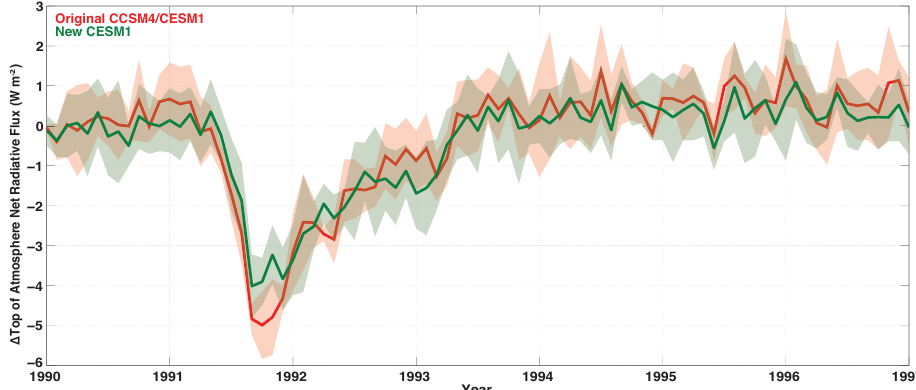
Figure 4. Global, monthly, ensemble, and mean change in the top of atmosphere radiative flux due to the simulated Mt. Pinatubo eruption in June of 1991. Each original and new volcanic ensemble member is differenced from a set of simulations (not shown) conducted with identical initial conditions but with no stratospheric AOD forcing. Shaded regions represent the ± 1 σ standard deviation of the